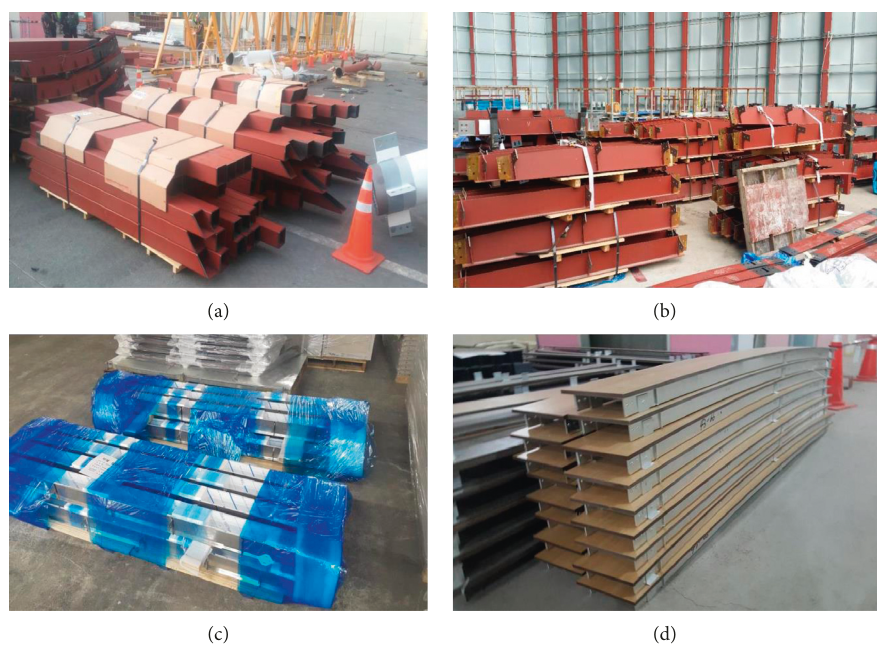
Figure 12: Warehousing of SSSs, T-BARS, reveals, and NT panels.